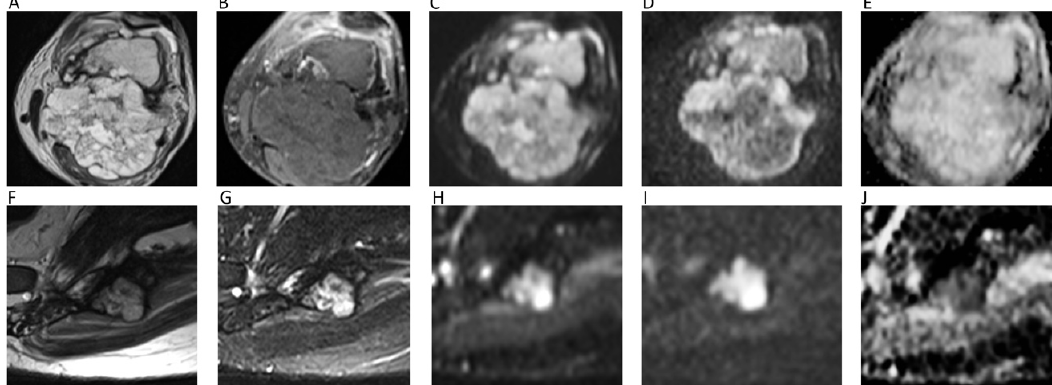
Figure 12. The left femur G3 chondrosarcoma ( A – E ) of a 76-year-old male patient. Axial T2w image ( A ) shows a hyperintense bone lesion with a large posterior soft tissue mass presenting poor contrast enhancement on fat-suppressed T1w image ( B ). The lesion shows high signal on b = 0 DWI image ( C ), decreased signal on b = 1000 DWI image ( D ), and unrestricted pattern of di ff usion on the corresponding ADC map ( E , mean ADC: 2.303 × 10 − 3 mm 2 / s). The Ewing sarcoma ( F – J ) of the left iliac bone of a 31-year-old male patient. The tumor presents as an esofitic bone lesion with intermediate signal on axial T2w image ( F ) and high signal on axial STIR image ( G ). The lesion shows intermediate-high signal on b = 0 DWI image ( H ), higher signal on b = 1000 DWI image ( I ), and restricted pattern of di ff usion on the corresponding ADC map ( J , mean ADC: 0.899 × 10 − 3 mm 2 /